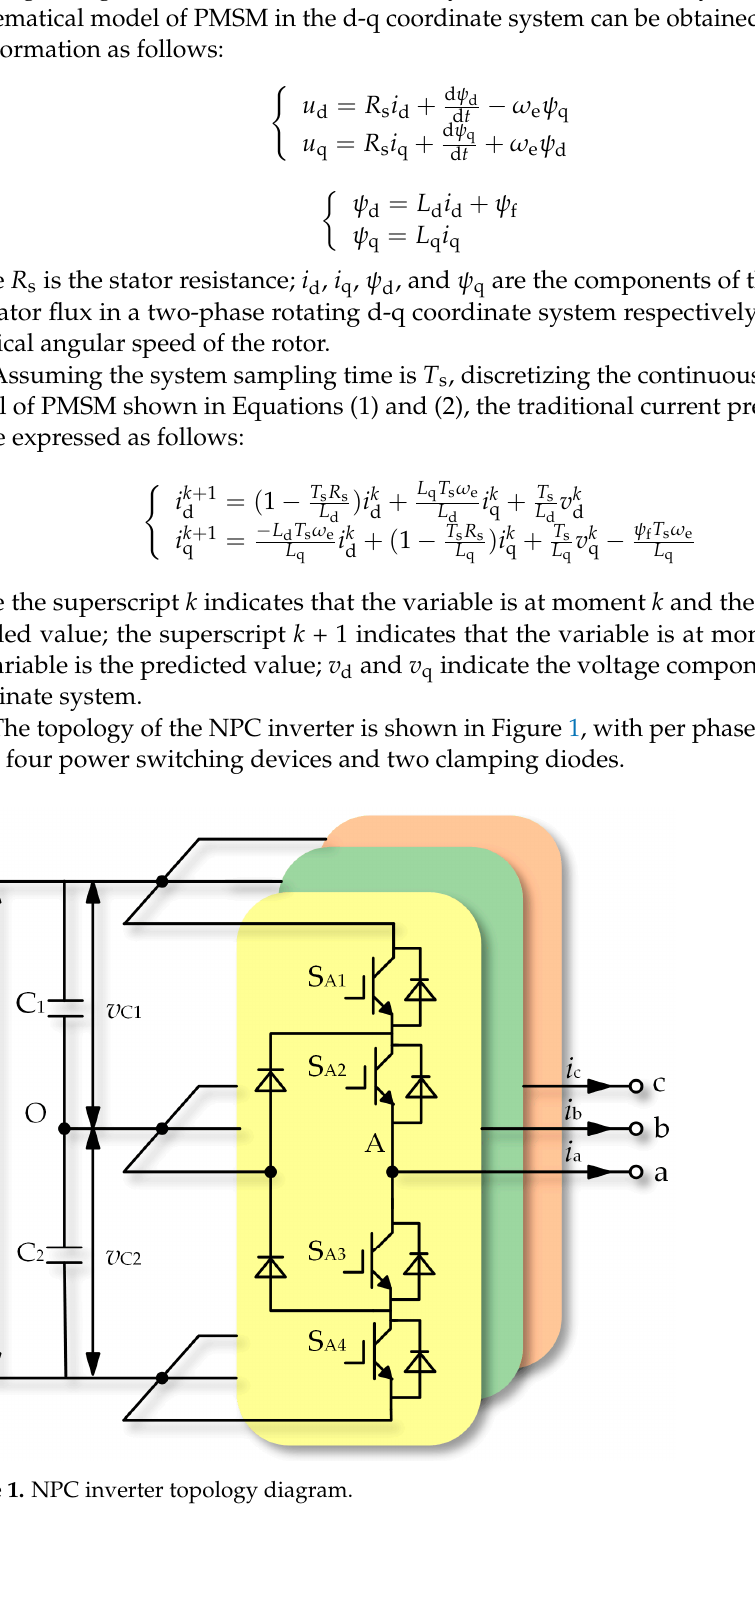
Figure 2. Space Vector diagram of NPC inverter.